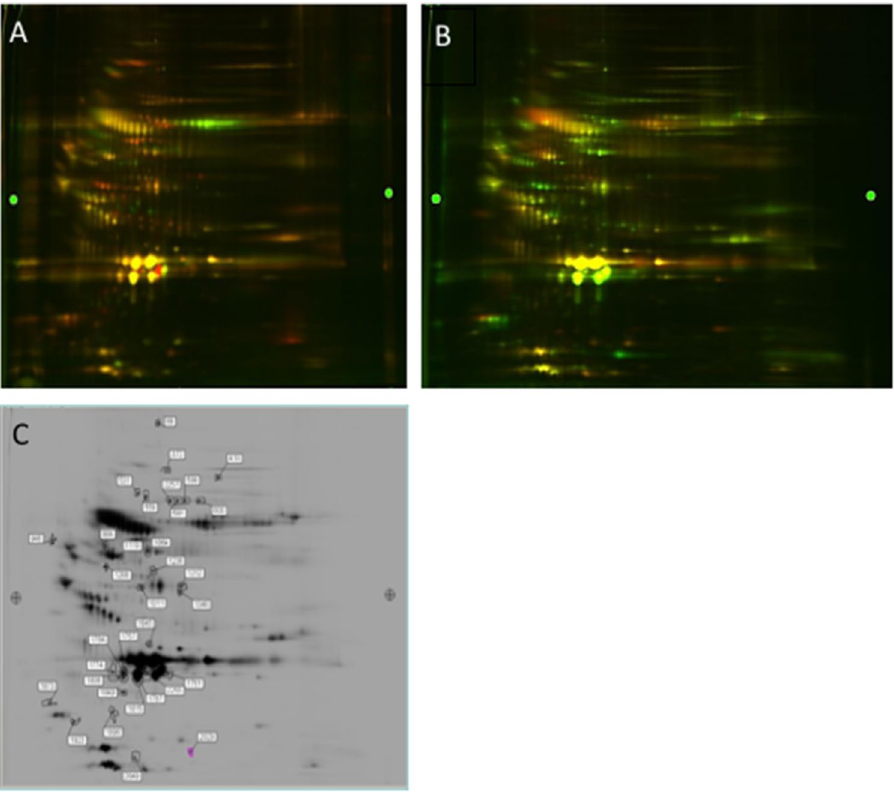
Figure 1. Differential in gel electrophoresis (DIGE) separation of serum proteins. After labeling, the extracted proteins from the serum samples were mixed and co-electrophoresed through the first- and second-dimension gels. (A) Comparison of a serum protein sample from a red tide manatee labeled with Cy3 (green dye) with a serum protein sample from a Crystal River manatee labeled with Cy5 (red dye). (B) Comparison of a serum protein sample from an IRL manatee labeled with Cy5 (red dye) with a serum protein sample from a Crystal River manatee labeled with Cy3 (green dye). (C) Coomassie blue stained gel showing the positions of the spots that were identified as differentially expressed for the gel in (A) and cut out for identification by mass